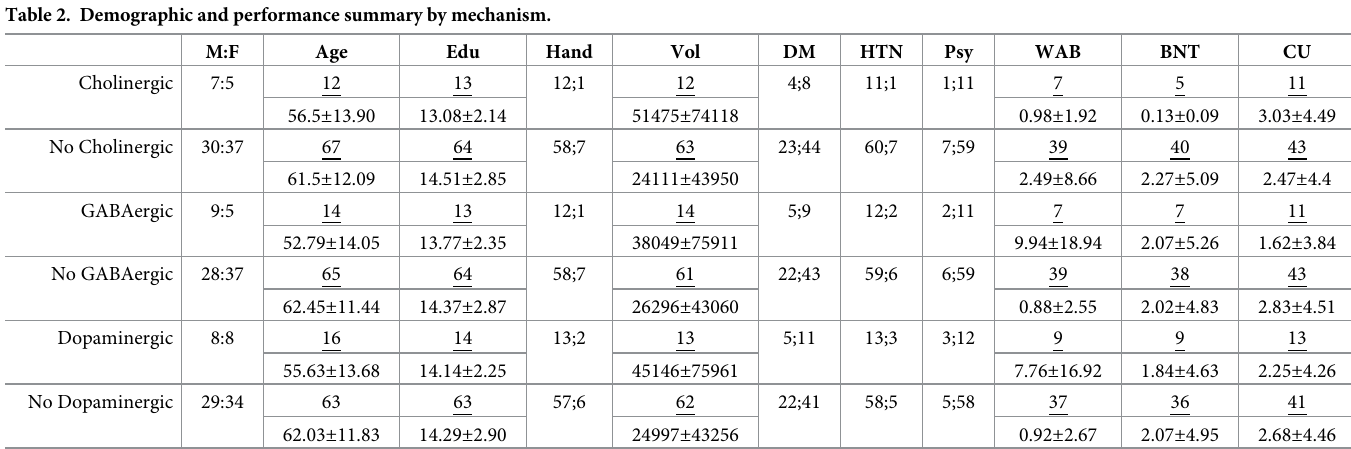
Continuous variables are reported as N Mean ± Standard Deviation. Edu: Education (in years). Hand: Handedness right: left. Vol: Acute lesion volume (mm 3 ). DM: Diabetes mellitus present;absent. HTN: hypertension present;absent. Psy: mental health diagnosis in chart at the time of admission present;absent. For assessments, scores in the table reflect standardized difference scores between acute performance and average chronic performance. Higher numbers are associated with greater recovery. WAB: Western Aphasia Battery Aphasia Quotient (omnibus measure of language). BNT: Boston Naming Test (picture naming of nouns). CU: Cookie Theft content units (content provided when describing a